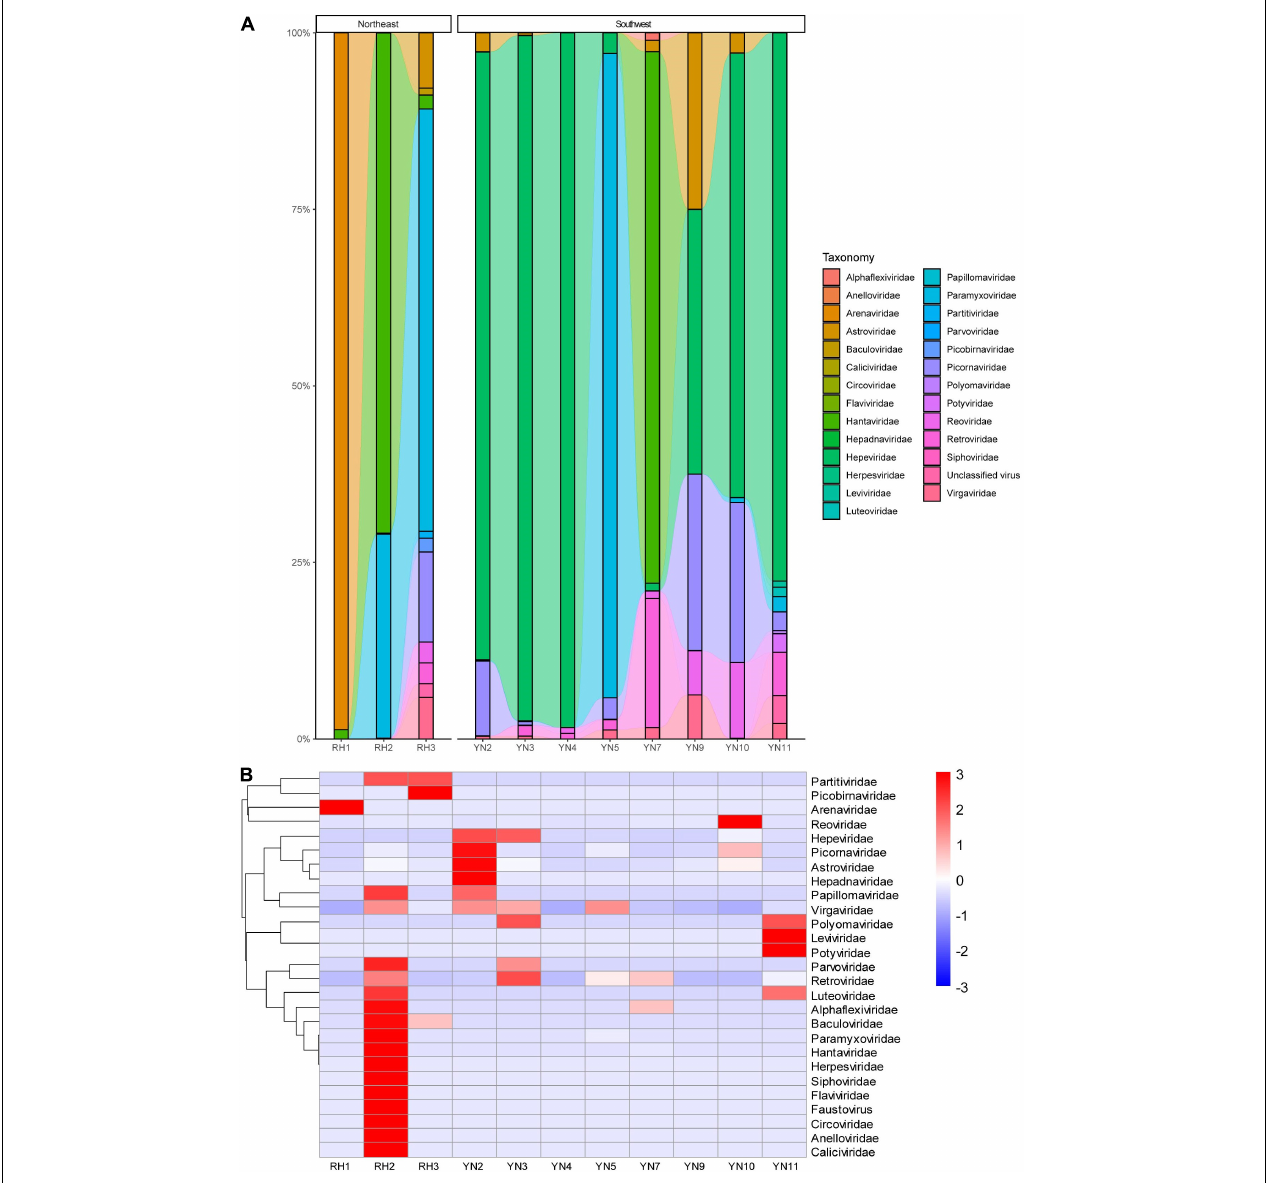
FIGURE 2 | (A) Comparative abundance composition of virus reads annotated in rodent specimens in Heilongjiang, Northeast China, and Yunnan, Southwest China. Virus families with low reads are invisible in the bar. (B) Heatmap of the viruses annotated in rodents from Northeast and Southwest